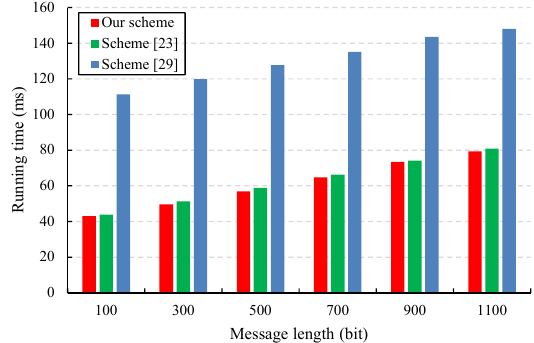
Figure 5. A comparison of the signature generation cost.